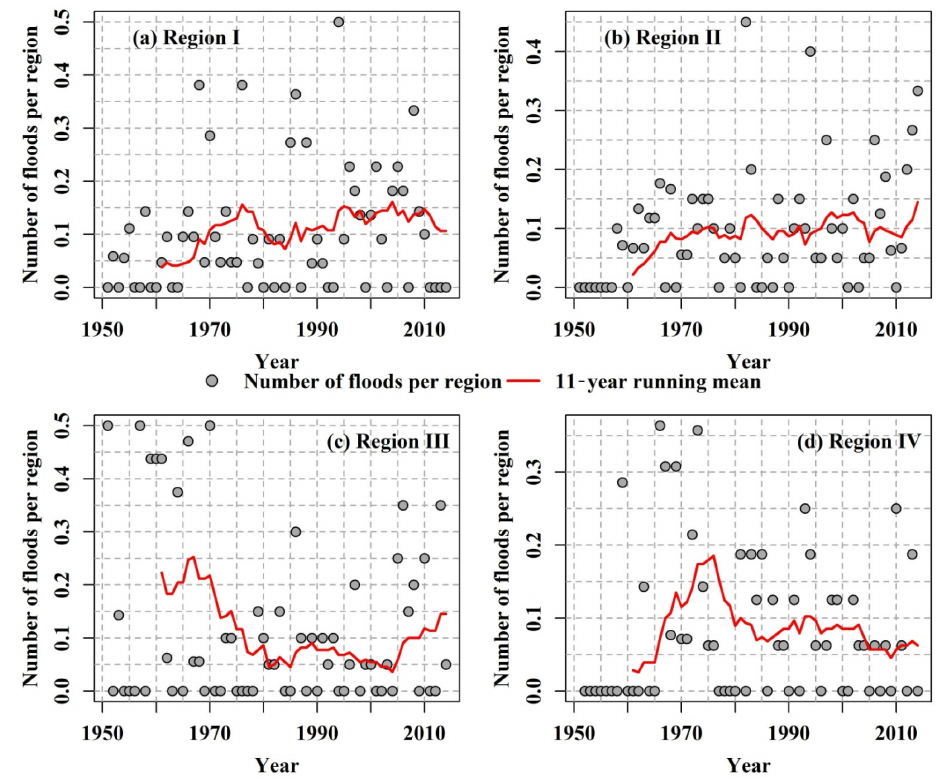
Figure 8. Temporal changes of percentage of stations with flood events of magnitude of > 10-year flood